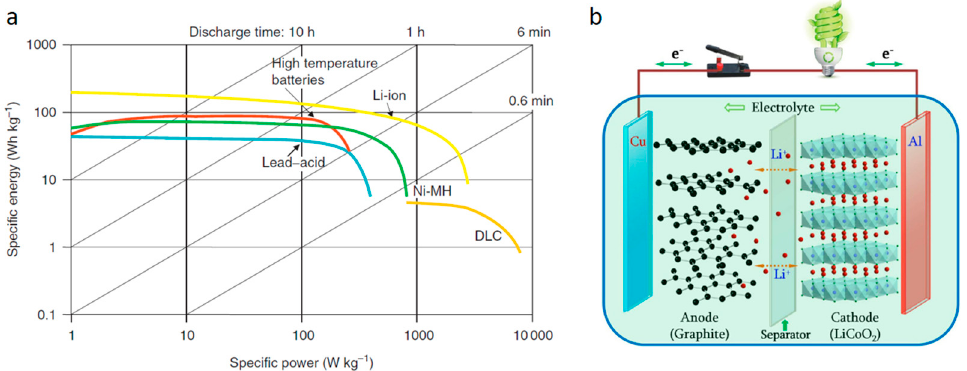
Figure 1. ( a ) Volumetric and gravimetric energy density of commercial battery technologies (Ragone plot). Reproduced with permission from [1]. ( b ) Conceptual representation of the reaction mechanism in a rechargeable LIB. Reproduced with permission from [2].